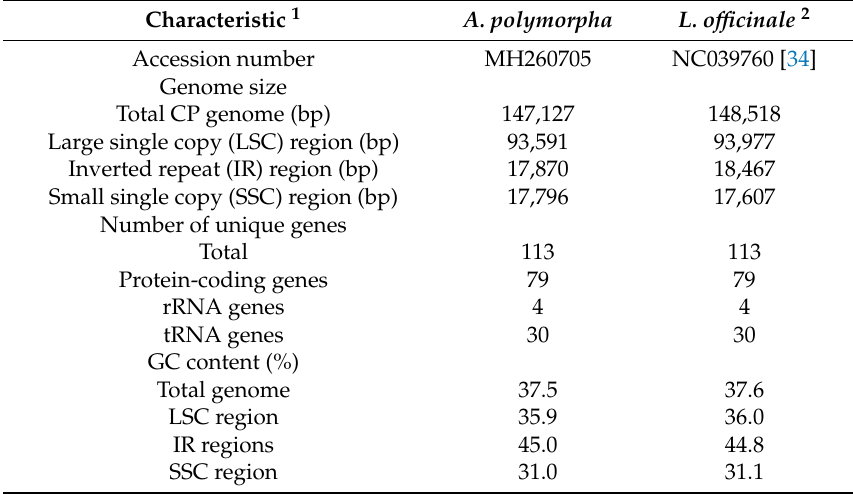
Table 1. Characteristics of the CP genomes of A. polymorpha and L. officinale